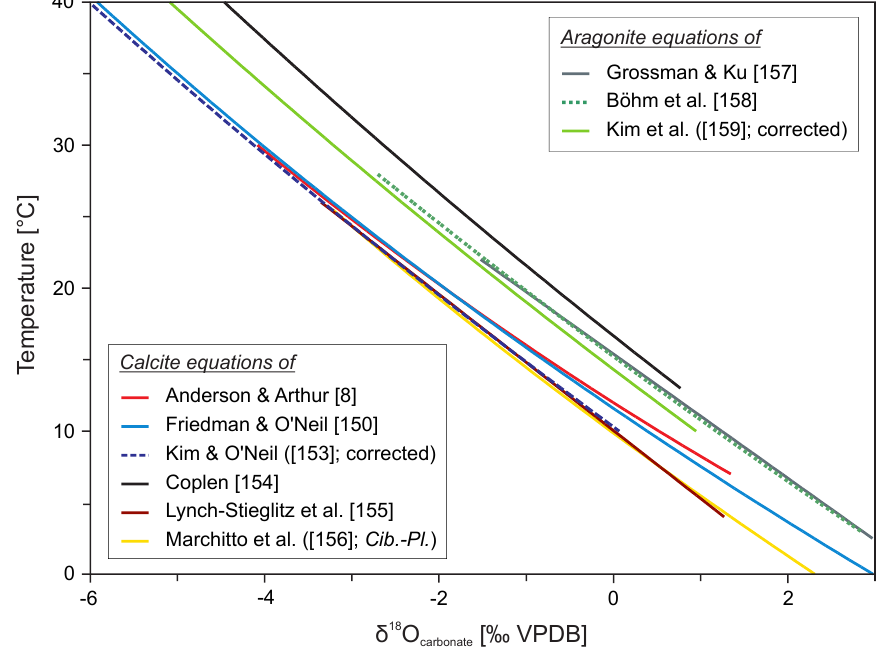
Figure 6. Comparison between published oxygen isotope temperature scales [8,150,153–159] comprising calcite-water and aragonite-water fractionation for δ 18 O water value = − 1‰ VSMOW, which is usually assumed as characteristic of an ice-free world (cf.